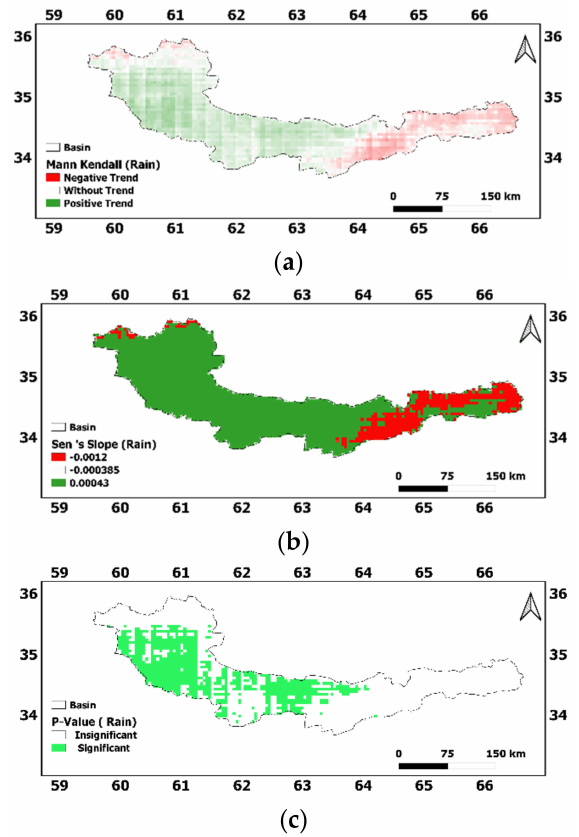
Figure 6. ( a ) Spatial distribution map of trend status of precipitation based on CHIRPS using Kendall estimator, ( b ) spatial distribution of trend intensity of precipitation (mm) using Sen’s slope estimator (Z = 1.96 at 95% confidence level), ( c ) spatial distribution of trend significance using p factor, over the 18-year period (2004–2021) at Doosti Dam’s